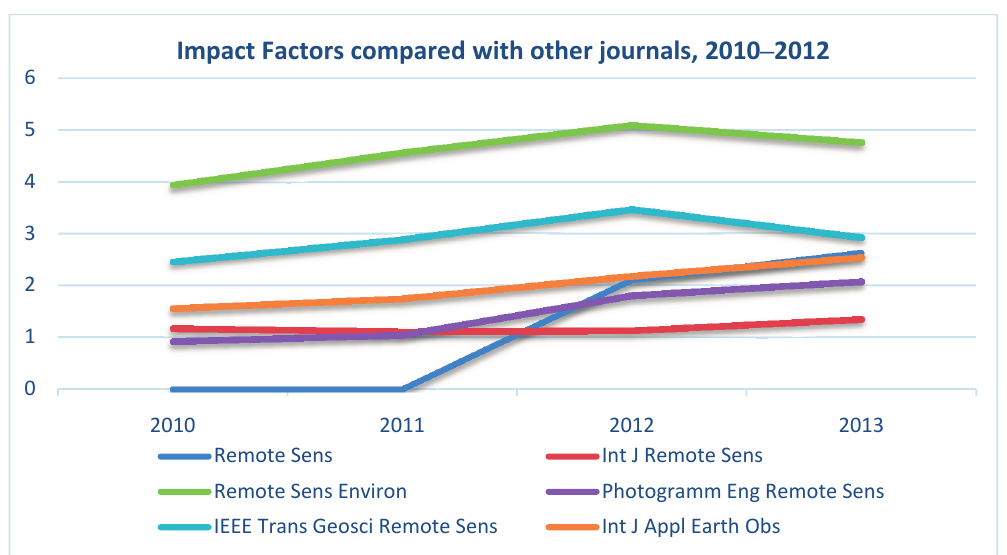
Figure 1. Impact Factor of Remote Sensing compared with some prominent remote sensing